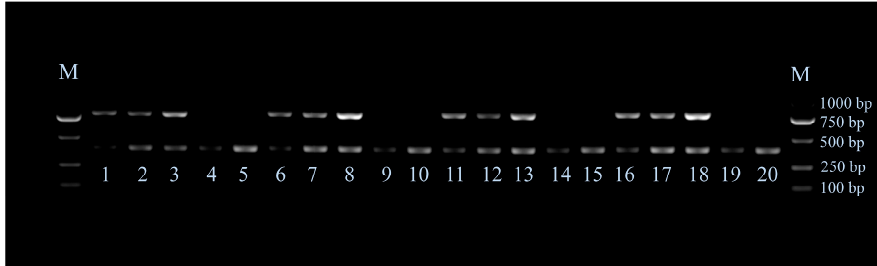
Figure 4. Patterns of the multiplex PCR agarose gel electrophoretic bands associated with different feathering genotypes. M represents DL2000 DNA Marker; The brightness of the bands is affected by dosage effect; 1, 6, 11, and 16 indicate K / − ; 2, 7, 12, and 17 indicate K / k + ; 3, 8, 13, and 18 indicate K / K ; 4, 9, 14 and 19 indicate k + / − ; 5, 10, 15 and 20 indicate k + / k +